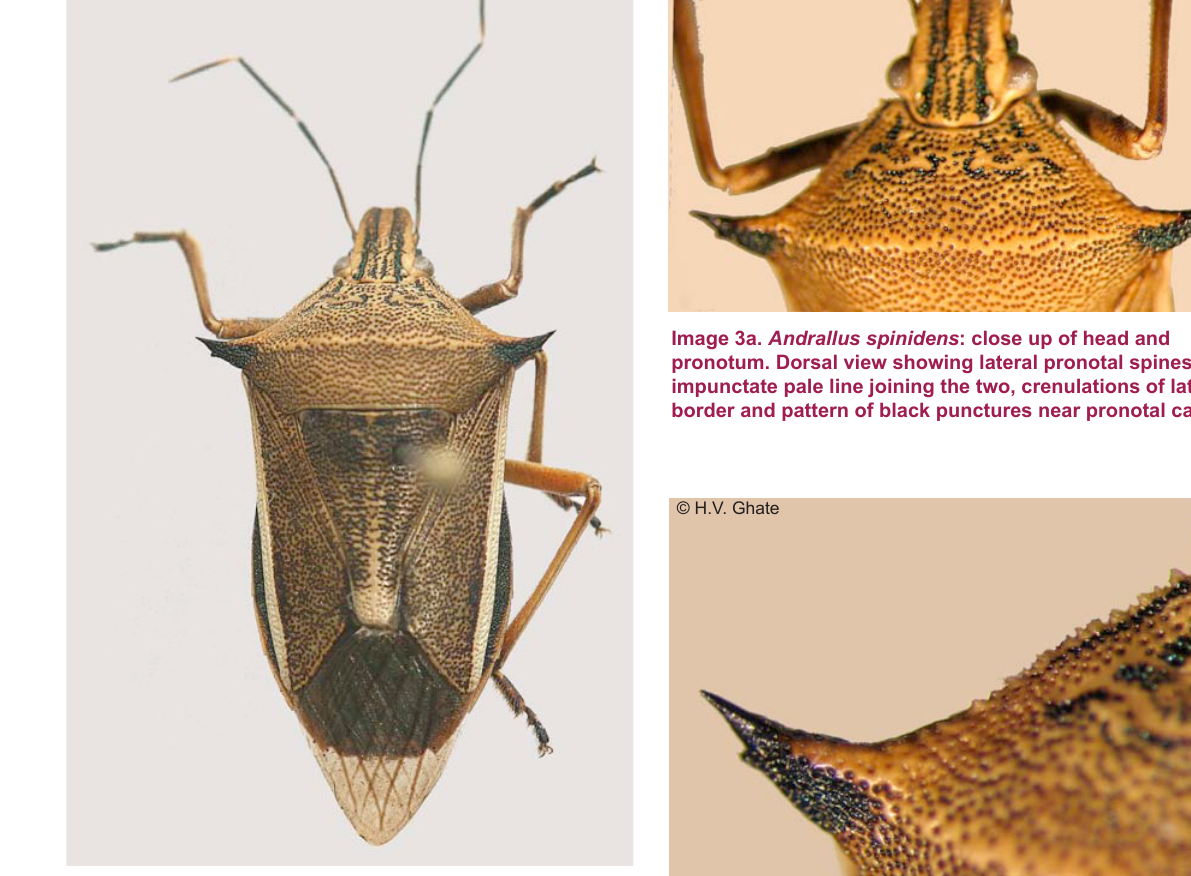
Image 1. Andrallus spinidens , dorsal view. Note the typical colour pattern and dark punctures on ochraceous body